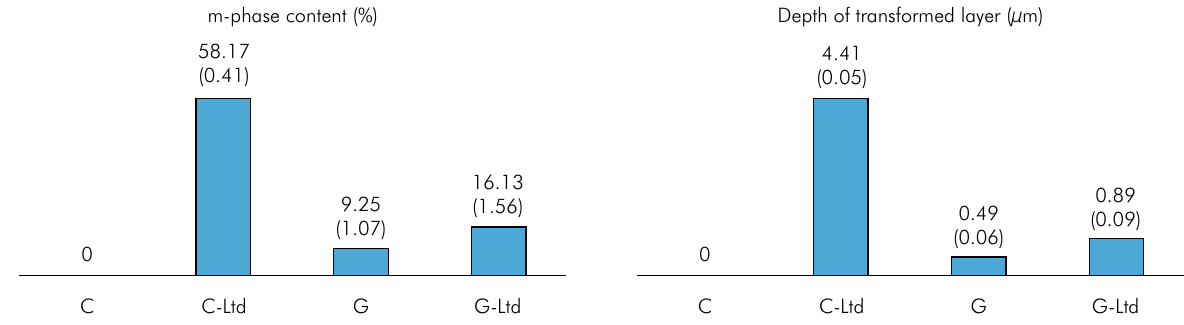
Figure 2. Mean percentage of monoclinic phase content (%) of the Y-TZP surface and depth of transformed layer (µm), in addition to their respective standard deviations (data inside parentheses). It highlights the highest m-phase content at as-sintered after aging condition (C-Ltd), as well as, the deepest layer of phase transformation (µm). Grinding procedure appears to trigger an initial m-phase content increase, although it prevents new phase transformation during aging (C- as-sintered; G- grinding; Ltd- low-temperature